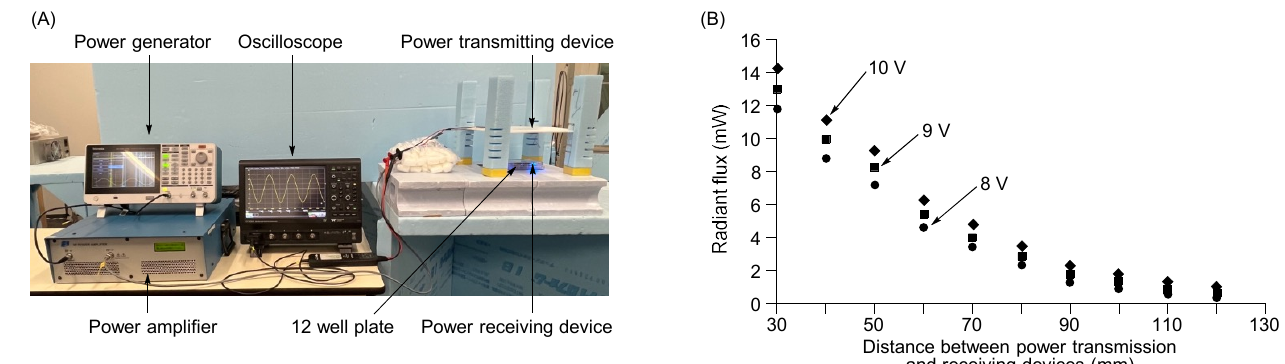
Figure 3. Evaluation of the function of the PT and PR in this study. ( A ) Experimental equipment consisting of an electric power generator, an AC power amplifier, an oscilloscope, and the PT and PR. ( B ) Measurement of radiant flux from LEDs on the PR at different input voltages (8 V ( • ), 9 V ( ■ ), and 10 V ( ♦ )) with different distances between the PT and PR (30–120